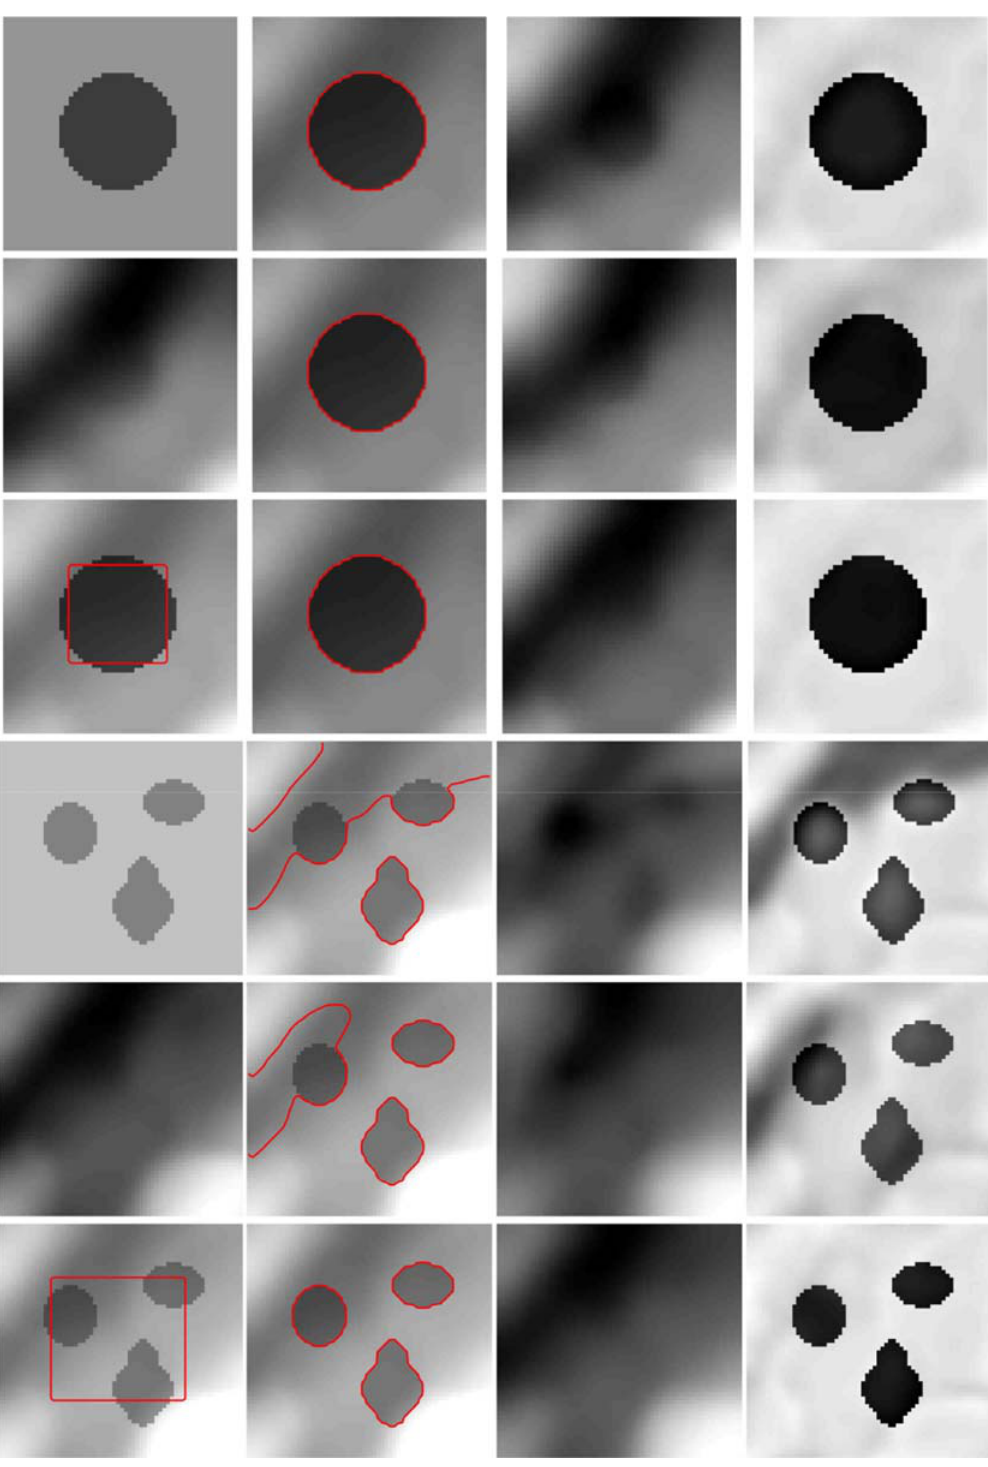
Fig 10. Comparisons of Li ’ s model, LSACM and our model for two synthesize images multiplied by given bias fields. Column 1 is the original images (row 1, 4), given bias fields (row 2, 5) and the initial contours in the images multiplied by bias fields (row 3, 6). Column 2 to 4 is the segmentation results, estimated bias fields and corrected images, respectively. Row 1 and 4 are the results of Li ’ s model. Row 2 and 5 are the results of LSACM. Row 3 and 6 are the results of our